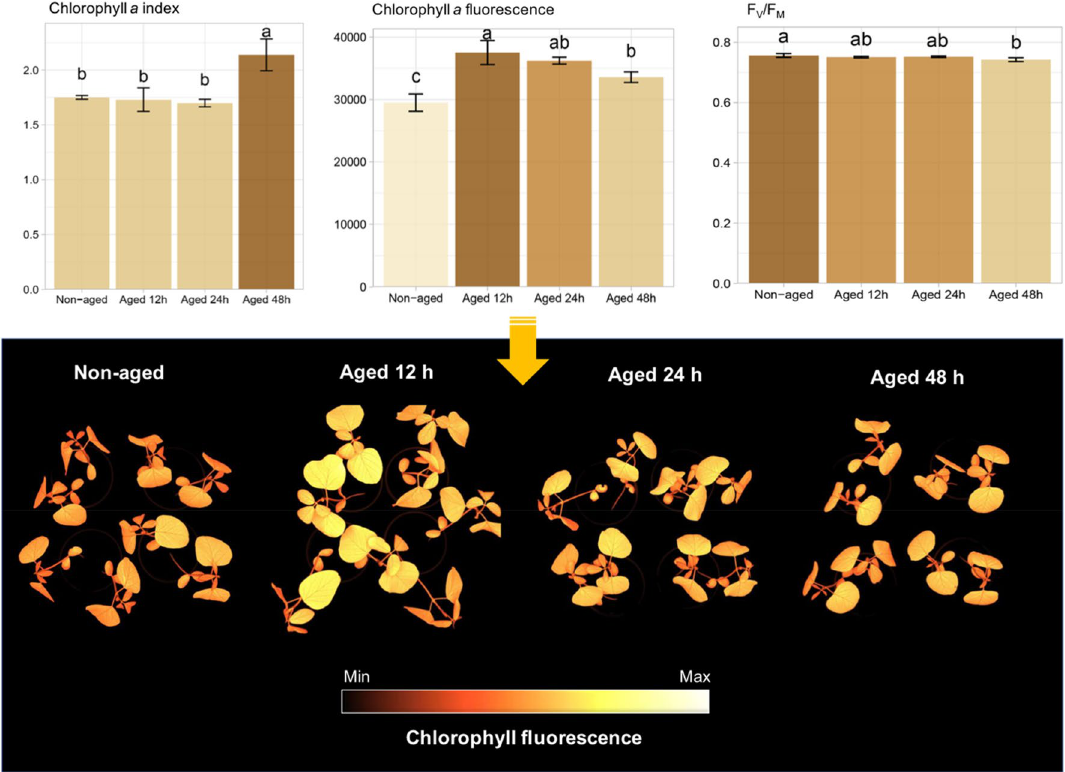
Figure 7. Chlorophyll a index, chlorophyll a fluorescence, and maximum quantum yield of photosystem II based on F V /F M in soybean seedlings grown from non-aged seeds and seeds aged for 12, 24 and 48 h on the 16th day after sowing. Means (± standard deviation) followed by the same letter are not significantly different according to Tukey test ( P <